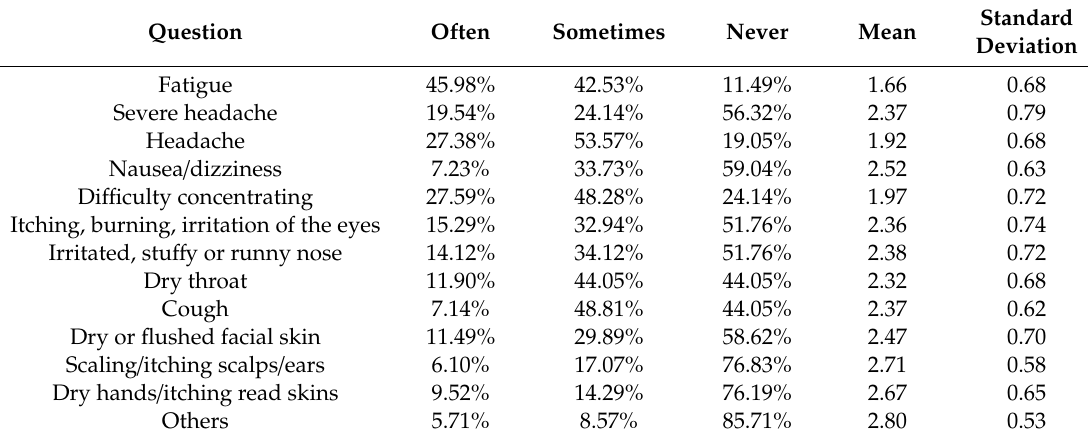
Table 2. Sick Building Syndrome (SBS) prevalence among sta ff